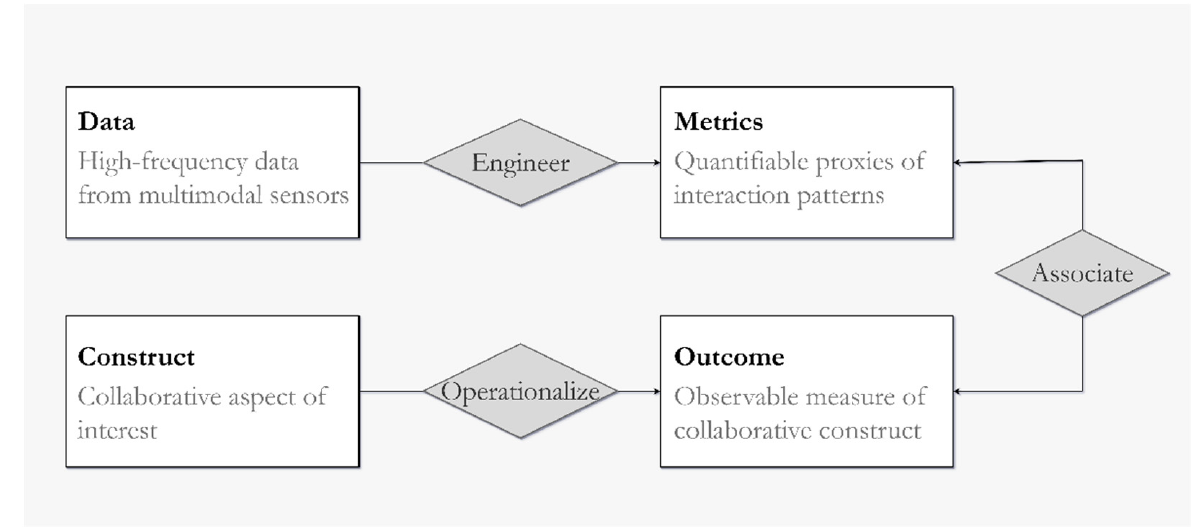
Figure 2. The MMCA data-construct framework.